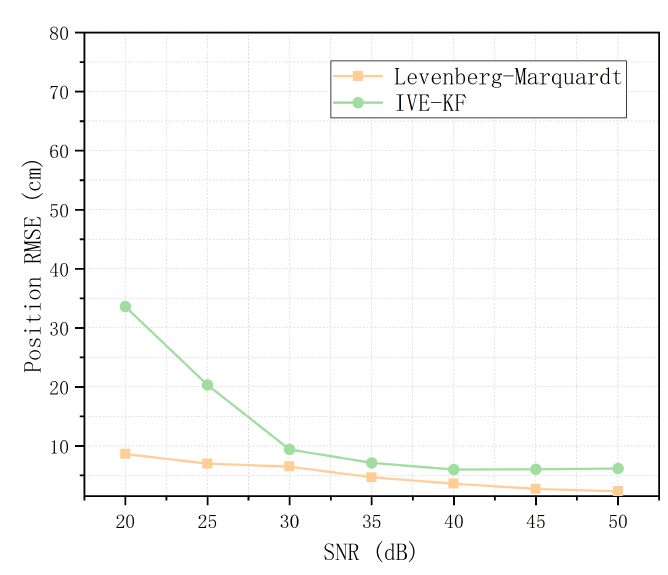
Figure 17. RMSE comparison of the position error between the inversion algorithm and filter algorithm.